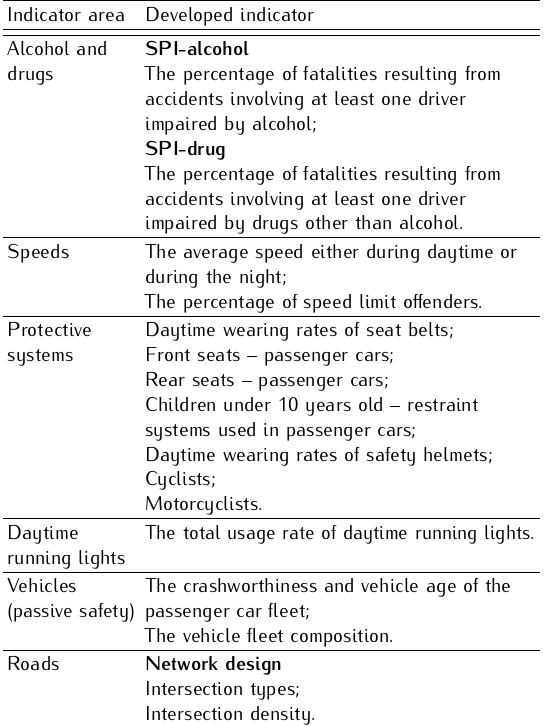
Table 1. Developed safety performance indicators Indicator area Developed indicator Alcohol and drugs